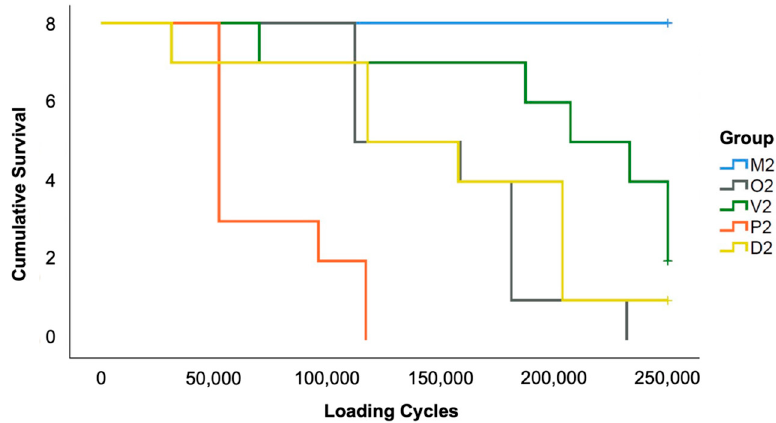
Figure 6. Kaplan–Meier survival rates of the FDPs during thermodynamic loading.